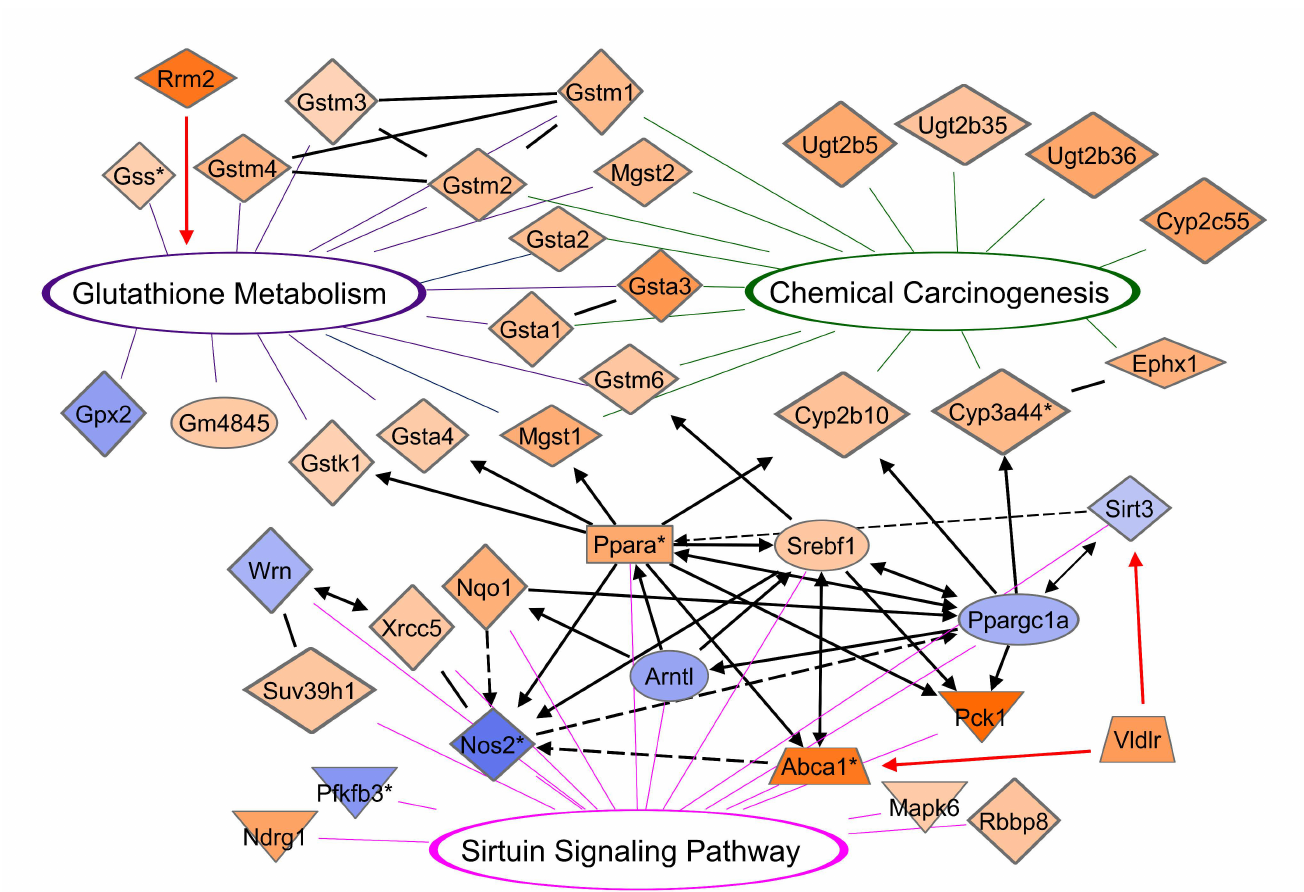
Figure 7. CR induces a network between proteins encoded by DEGs of glutathione, chemical carcinogenesis, and sirtuin signaling pathways. DEGs of glutathione metabolism (purple; mmu00480), chemical carcinogenesis (green; mmu05204), and sirtuin signaling pathways (magenta). Sirtuin signaling regulation has downstream targets in glutathione metabolism (Gstk1, Gsta4, Mgst1, Gstm6) and chemical carcinogenesis (Cyp2b10, Cyp3a44). Black lines indicate molecule relationships. Self-loops were removed for easier visualization of network interactions between molecules. Asterisks on molecules indicates druggable targets: Ppara (aleglitazar, atorvastatin/choline fenofibrate, bezafibrate, clofibrate, docosahexaenoic acid, ezetimibe/fenofibrate/simvastatin, gemfibrozil, NS-220, pemafibrate, TPST-1120, tesaglitazar), Nos2 (GW 273629, N(G)-monomethyl- D -arginine, pimagedine, triflusal), Cyp3a44 (atazanavir/cobicistat/darunavir), Abca1 (probucol), Gss ( N -acetyl- L -cysteine), Pfkfb3 (PFK-158). All DEGs encoding these proteins are adjusted p -value < 0.05 at |FC| > 1.5, except Sirt3 with